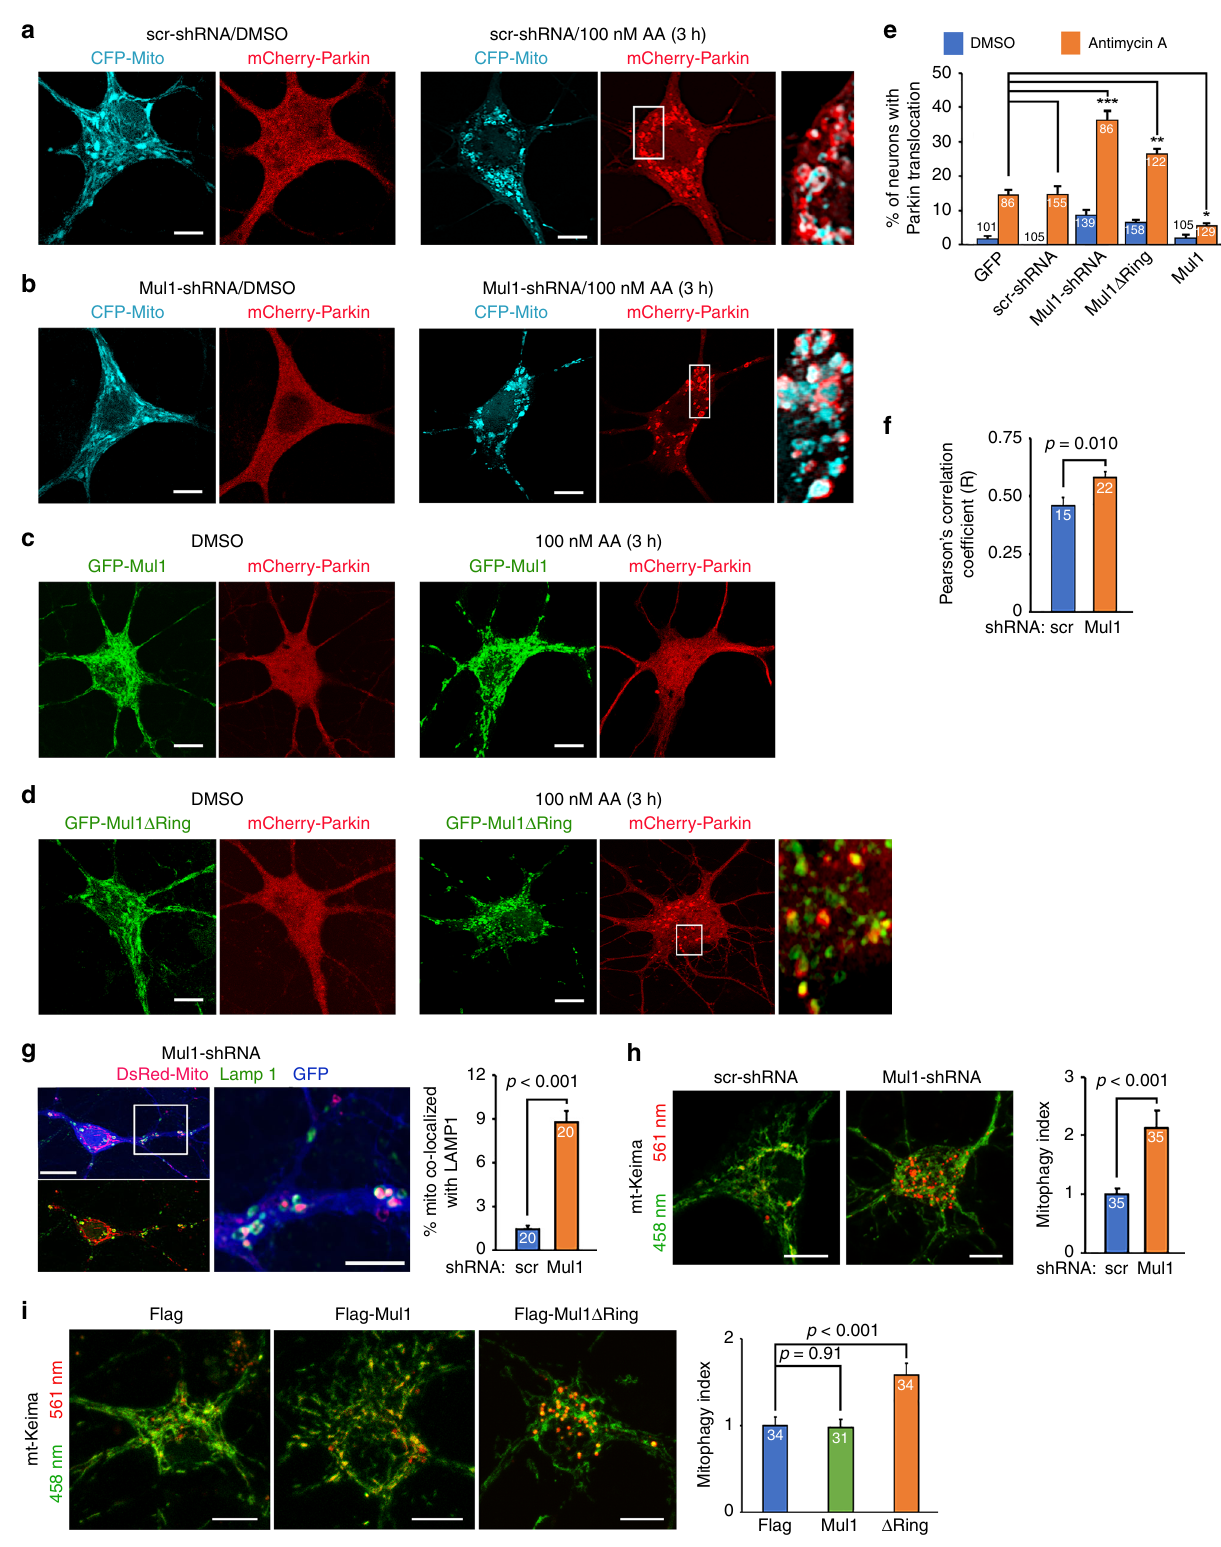
DIV14-15 when compared to DIV10-11. No signi fi cant change in ATP levels was detected in neurons expressing Flag vector or WT Mul1 between these two-time points. These data indicate that Mul1 de fi ciency impairs mitochondrial integrity and thus ATP production at DIV14-15, a time point associated with mitochondrial fragmentation. To further con fi rm